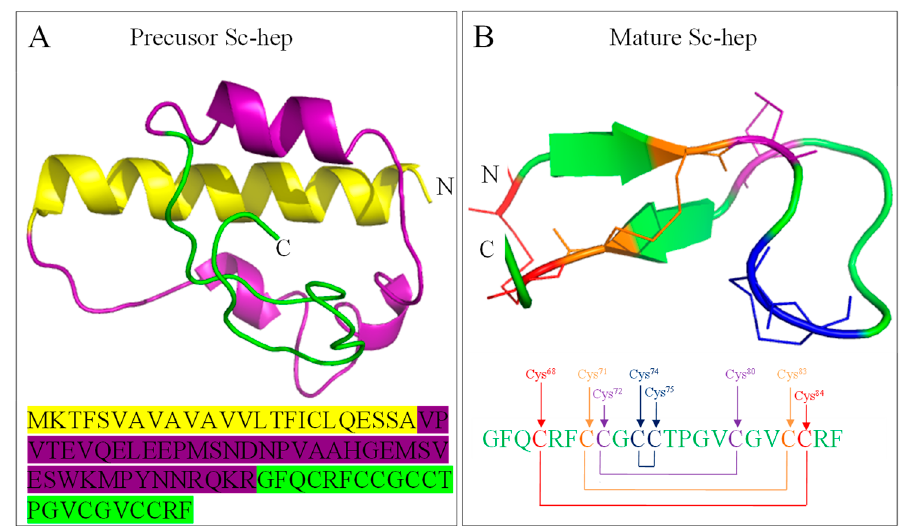
Figure A1. Structure prediction of the Sc-hep protein. ( A ): Protein structure of the precursor Sc-hep. The yellow region is the signal peptide with an α -helix structure. The purple region is the propeptide with a random coil structure. The green region is the mature peptide with a β -sheet structure. ( B ): Structure of the mature Sc-hep protein. Four disulfide bonds are formed by eight cysteine residues to stabilize the whole fold of mature Sc-hep. The connection mode is distinguished by different colors. The red, orange, purple, and blue regions represent Cys68–Cys84, Cys71–Cys82, Cys72–Cys80, and Cys74–Cys75, respectively.